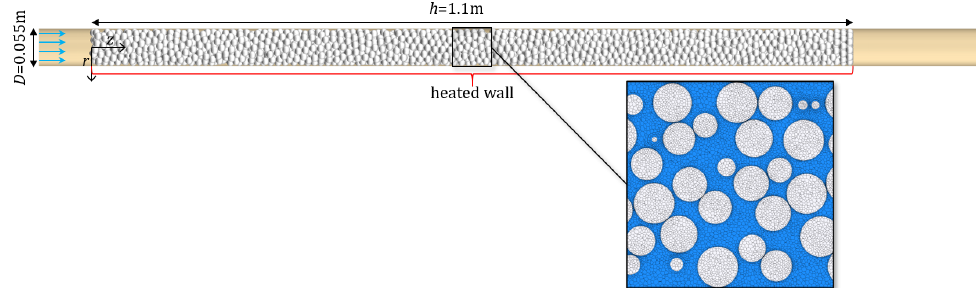
Figure 5. Schematic drawing of the numerical setup, including a snippet of the mesh. Exemplarily shown for the loose packing of